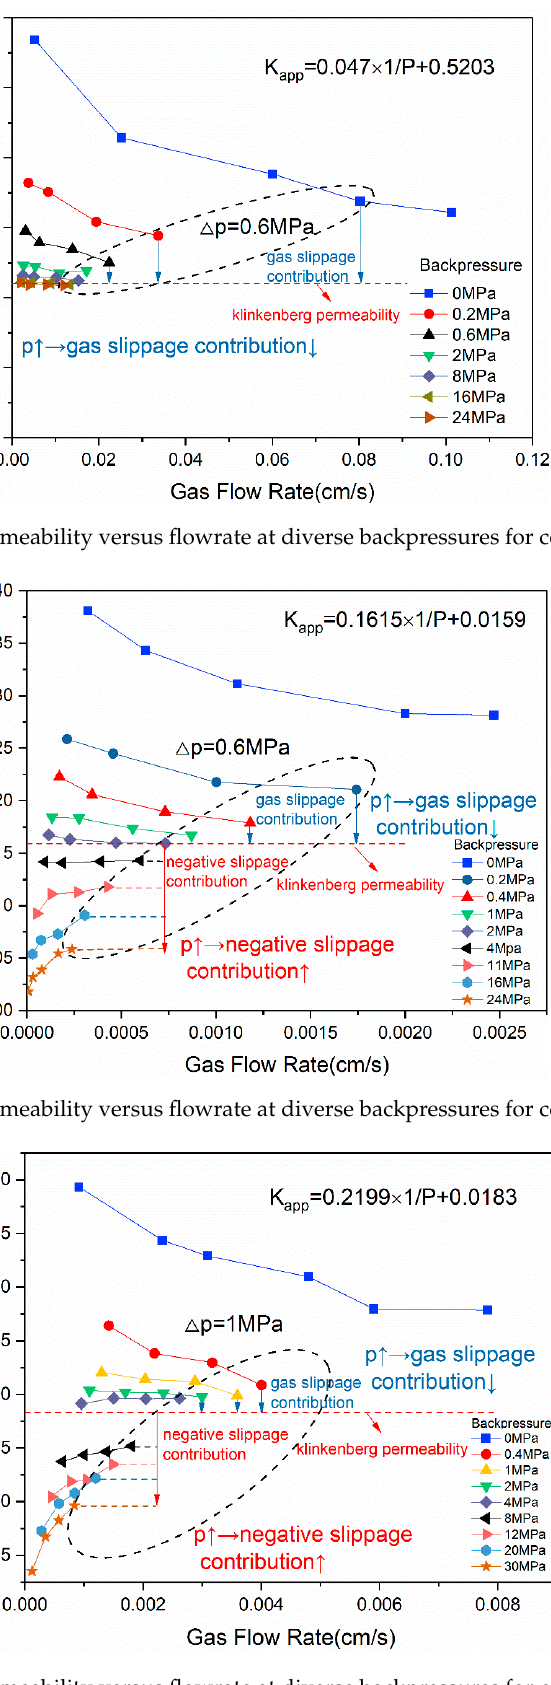
Figure 6. Permeability versus flowrate at diverse backpressures for core Z3.